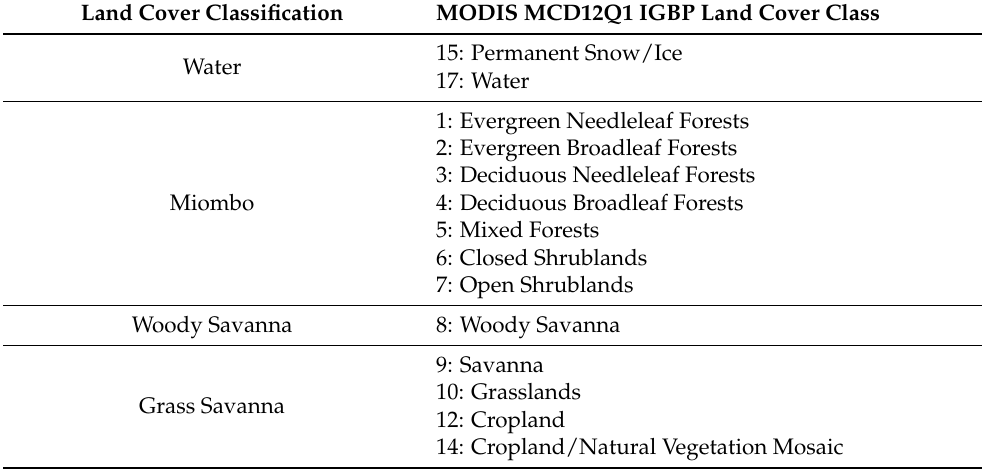
Figure 3. ( a ) Stationary land cover map based on Moderate Resolution Imaging Spectroradiometer (MODIS) MCD12Q1 Version 6 data for three wet years (2010–2012), along with ( b ) threshold-area curves for 2009–2018. The black line indicates the permanent wetland area of the stationary land cover map. ( c – h ) Histograms of wetland and non-wetland pixels from training data using: ( c ) Near-Infrared Reflectance (NIR) data; ( d ) the Normalized Difference Vegetation Index (NDVI); ( e ) the Normalized Difference Water Index (NDWI); ( f ) Tasseled Cap (TC) Brightness; ( g ) TC Greenness; ( h ) TC Wetness. Table 2. Land cover